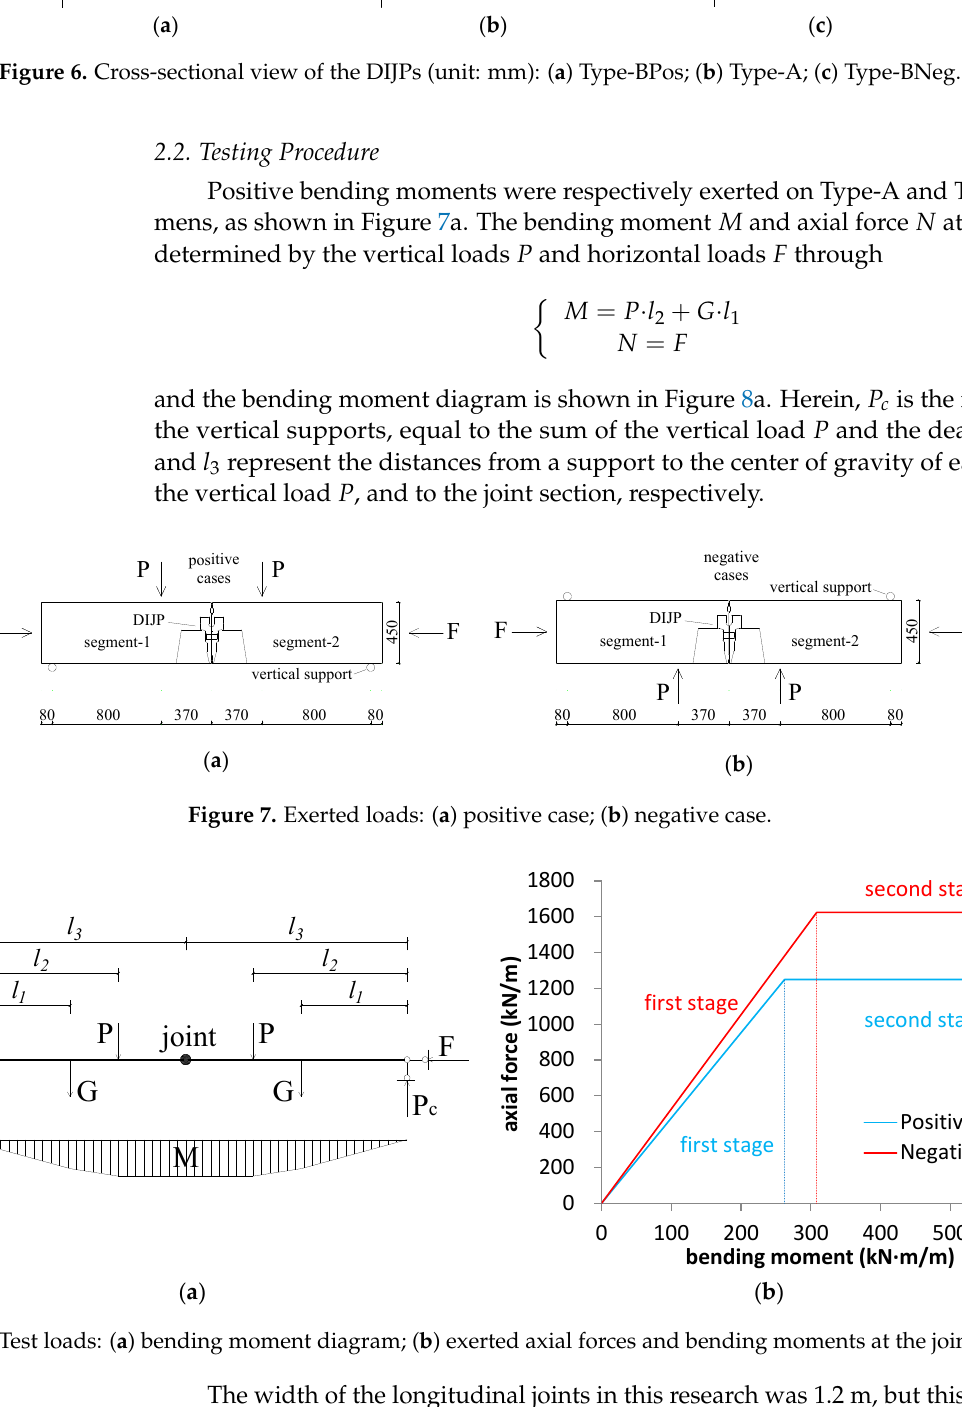
Figure 6. Cross-sectional view of the DIJPs (unit: mm): ( a ) Type-BPos; ( b ) Type-A; ( c ) Type-BNeg.